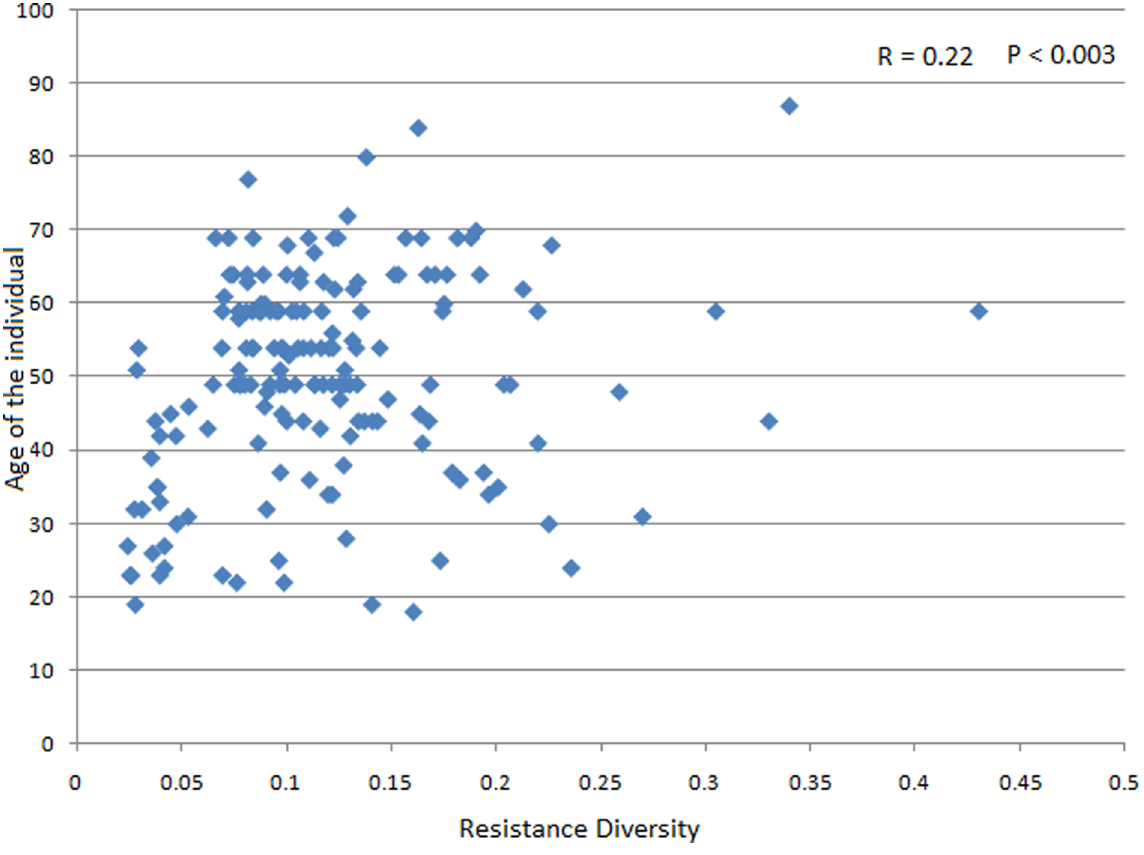
Figure 4. Variation of the antibiotic resistance diversity (in the 267 adult gut microbiomes) with the age of the individuals. Details on the names of the different gut microbiomes indicated in the figure are provided in Table S1.